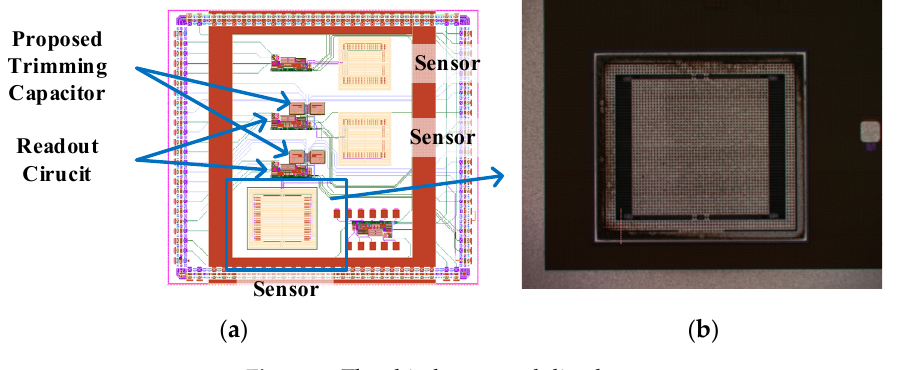
Figure 8. The chip layout and die photo.